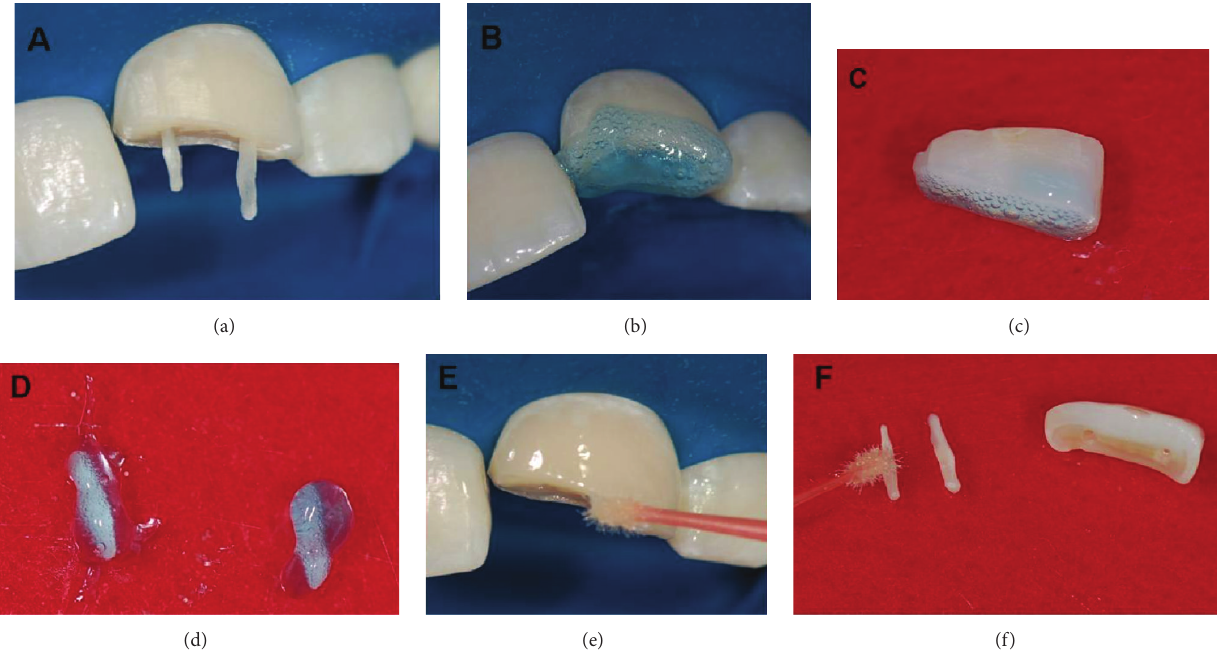
Figure 7: (a) Sample of the biopins in the holes made in the remaining tooth. (b) Acid conditioning of remaining tooth. (c) Acid conditioning of dental fragment. (d) Acid conditioning of the biopins. (e) Application of the primer/adhesive on the remaining teeth. (f) Application of the primer/adhesive in the biopins and dental